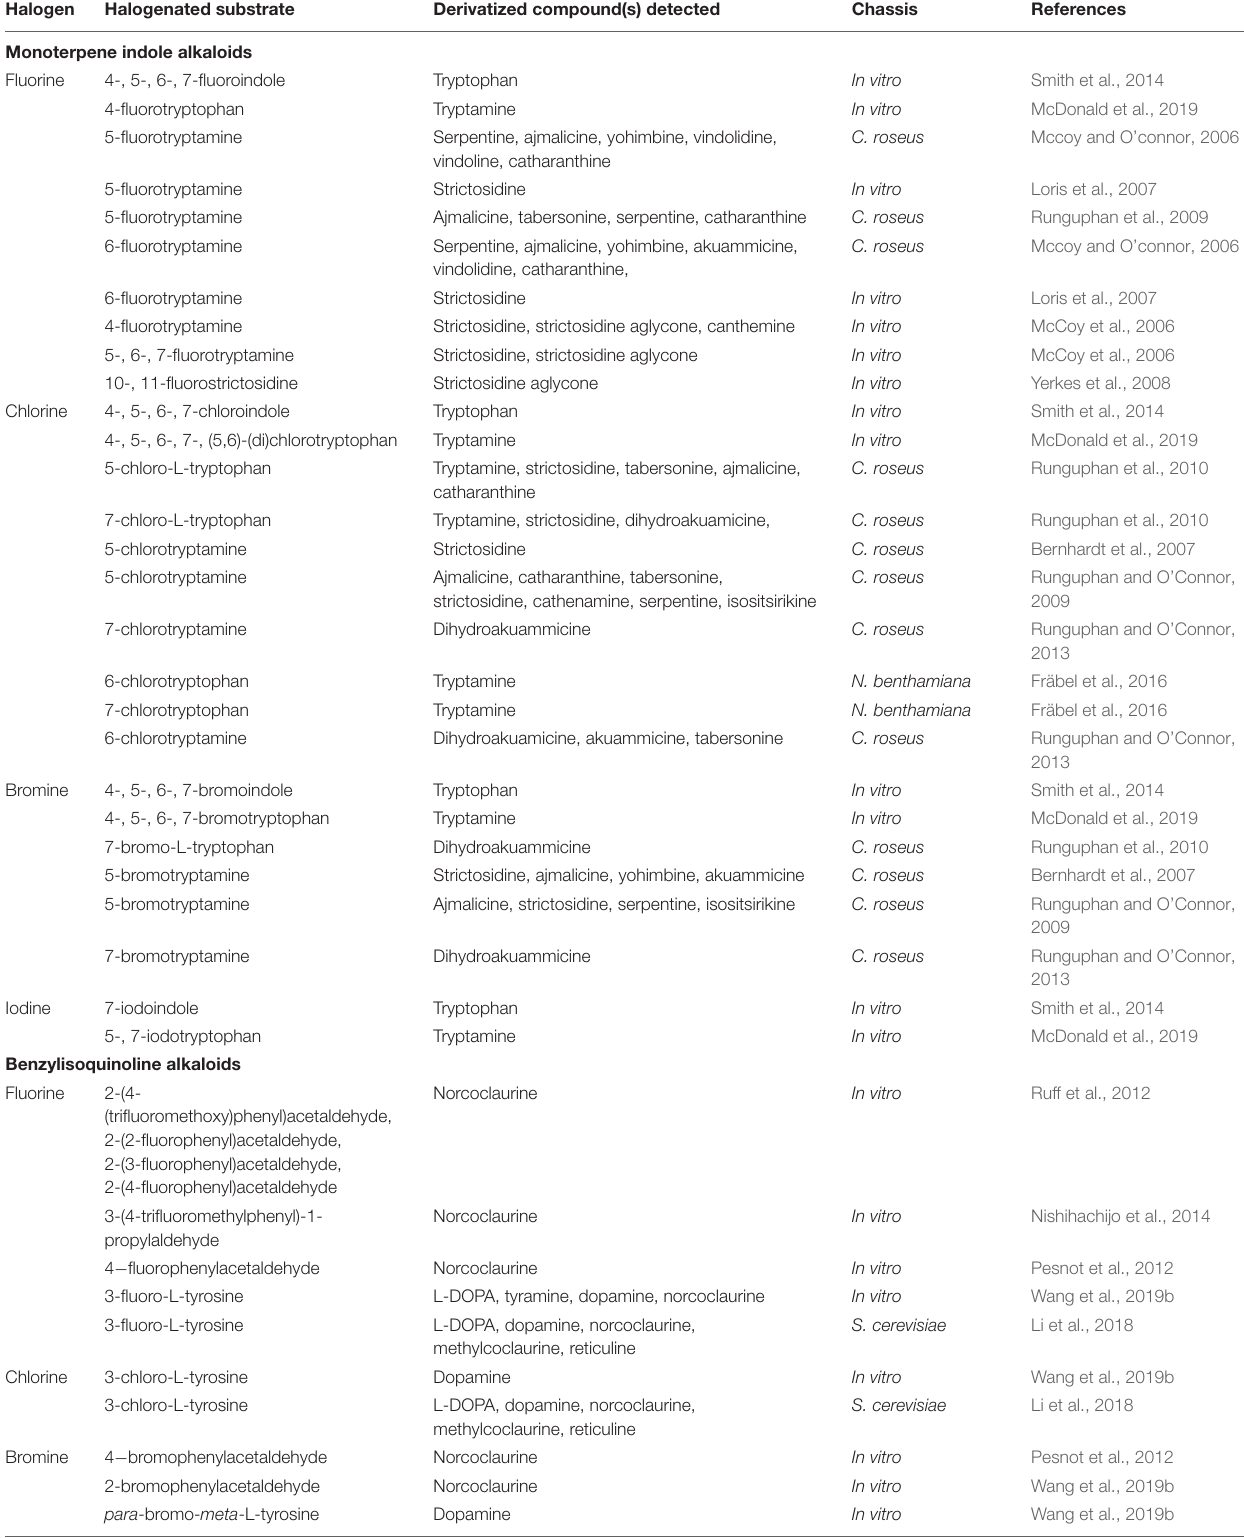
TABLE 2 | Enzymatically produced alkaloids from halogenated substrates.